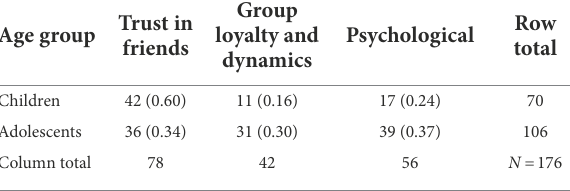
Observed values are reported with proportions within group in